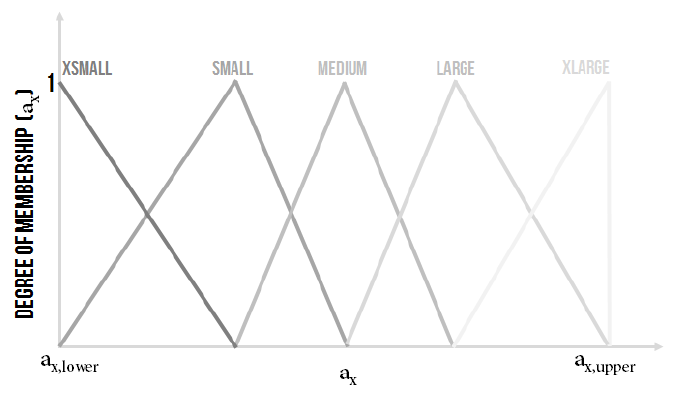
Figure 11. The other possible shape of the membership functions of linguistic values for the input linguistic variable a 2 , a 1 and a 0